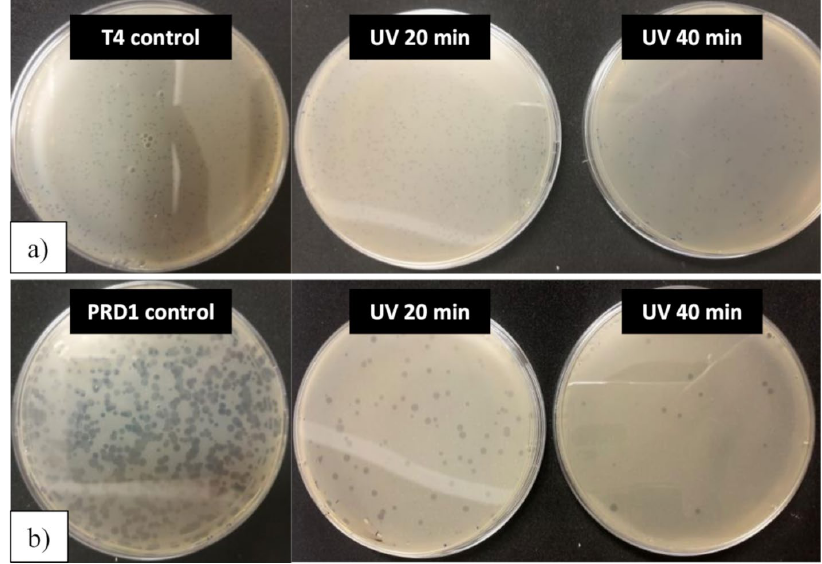
Fig. 4. Formation of plaques by bacteriophages T4 (a) and PRD1 (b) treated in mixture. Photocatalytic treatment was performed using UV light and P25 TiO 2